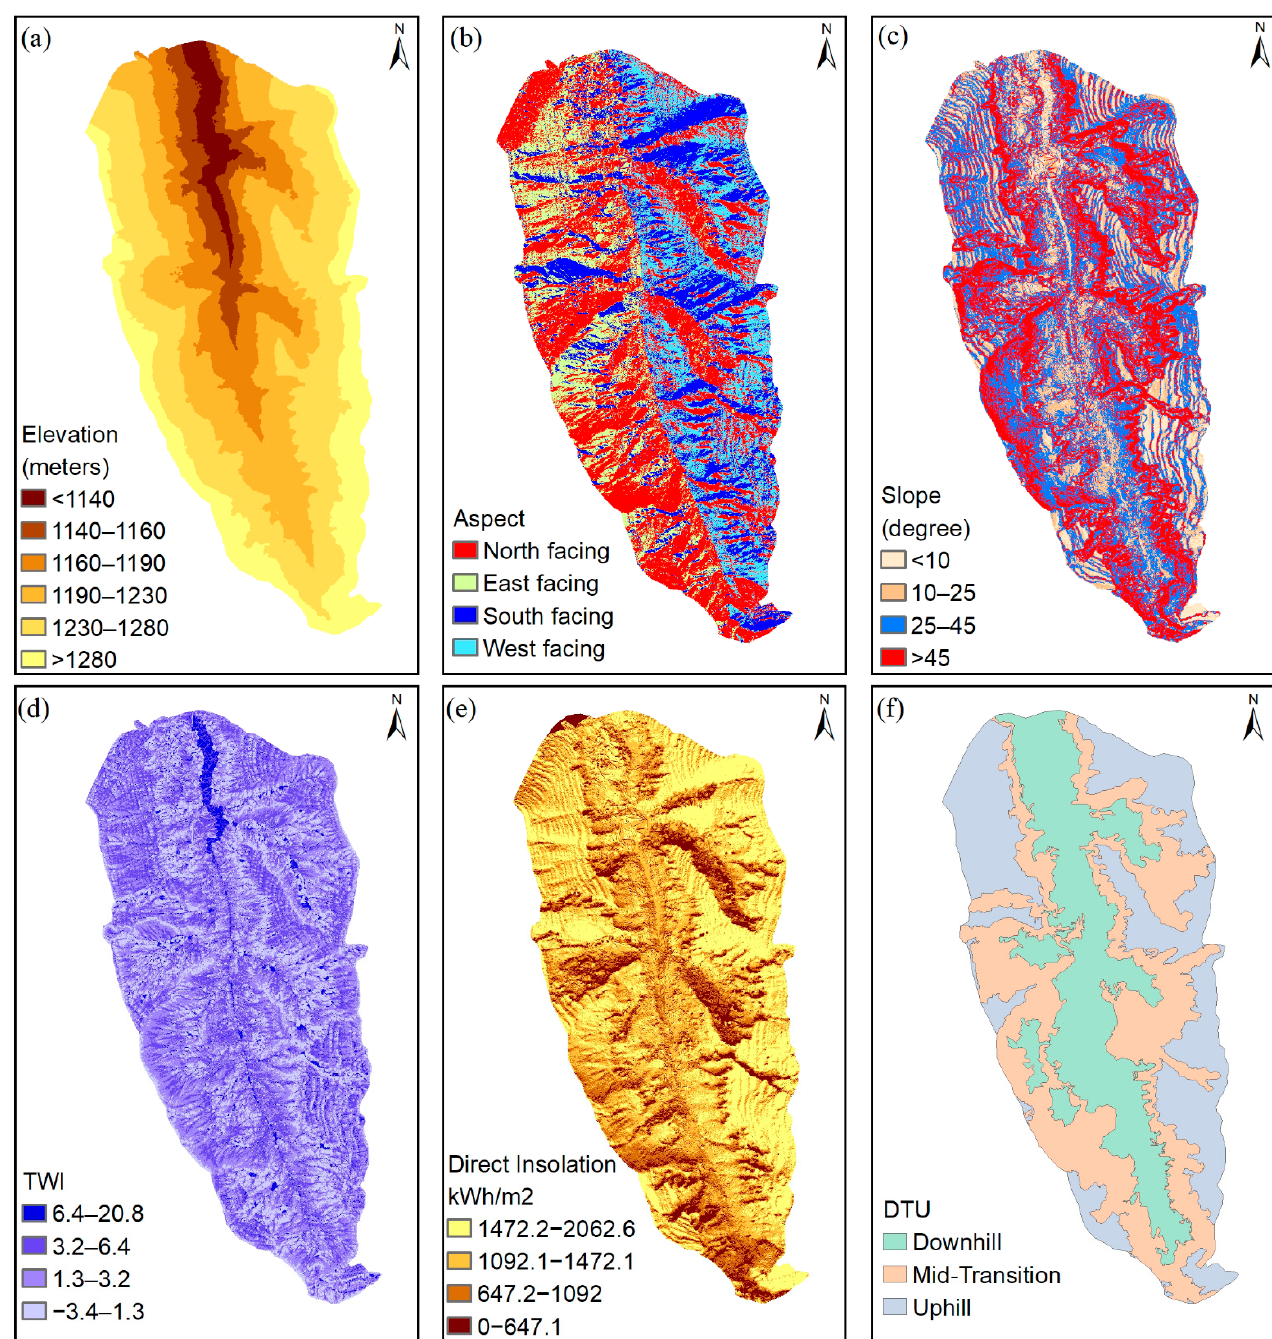
Figure 4. Distribution of topographical features in the Yangjiagou forest catchment: ( a ) Elevation, ( b ) Aspect, ( c ) Slope, ( d ) TWI, ( e ) Direct insolation, ( f ) DTU system, the three different landform units (downhill slope, middle transition zone, uphill slope).